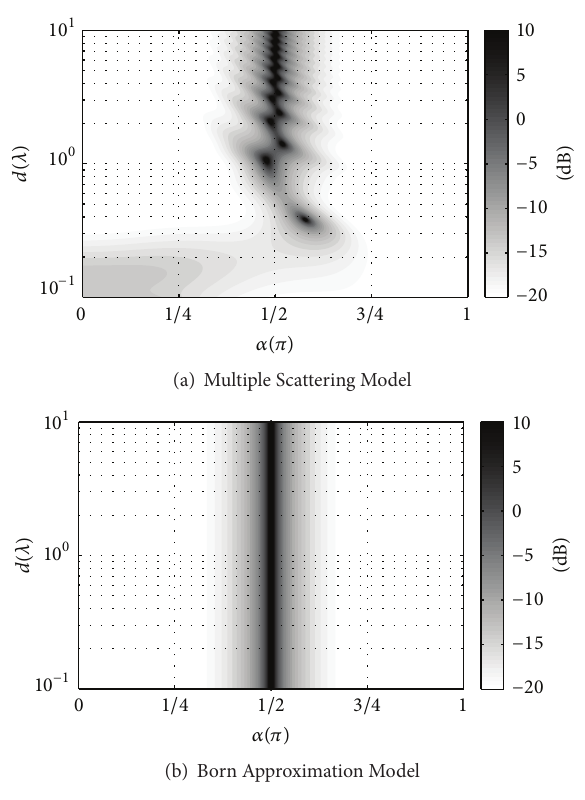
Figure 3: Plots of CRB (𝑑) as a function of incidence angle 𝛼 and scatterer separation 𝑑 , normalized by 𝜎 2 , for the case where 𝑑 1 is known. The observation angle 𝛽 = 𝜋 − 𝛼 and 𝜏 1 = 1 = 𝜏 2 .